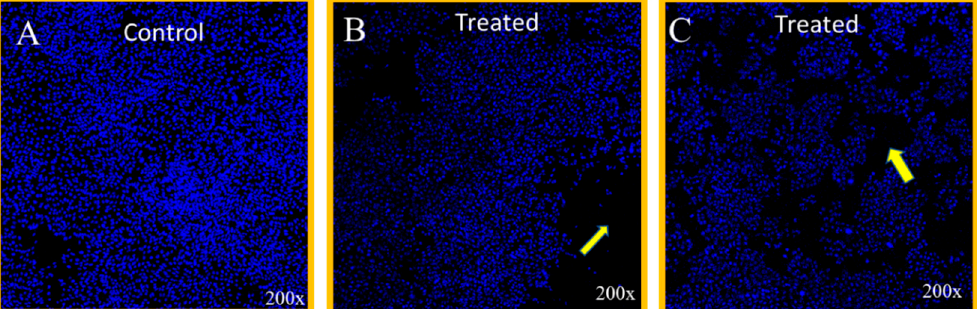
Figure 5. DAPI-stained cancer cell morphology. HCT-116 cells treated with ultrasonicated Mn 0.5 Zn 0.5 Er x Y x Fe 2 − 2x O 4 NPs (x = 0.02, 0.10) for 48 h. ( A ) shows the untreated cells (control); ( B) shows NPs treatment x = 0.02 concentration 0.88 µg/mL; and ( C ) shows treatment with x = 0.10 concentration (0.45 µg/mL). Arrows in ( B ) and ( C ) show the nuclear disintegration. 200x magnifications.